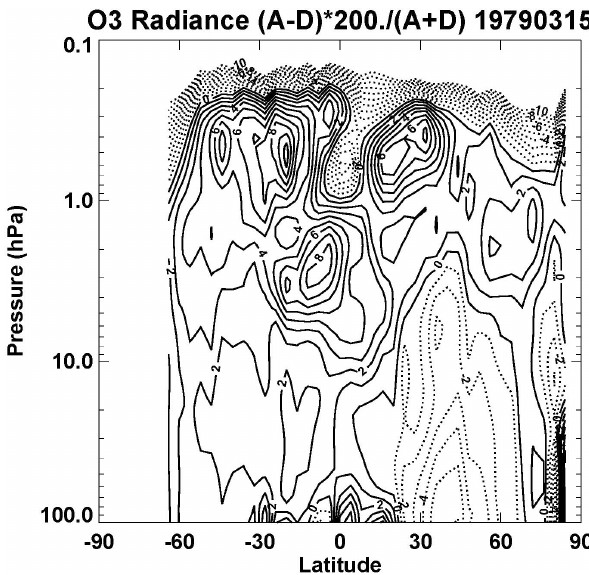
Figure 5. Ascending minus descending ozone radiance differences (in %) for 15 March 1979. Contour interval is